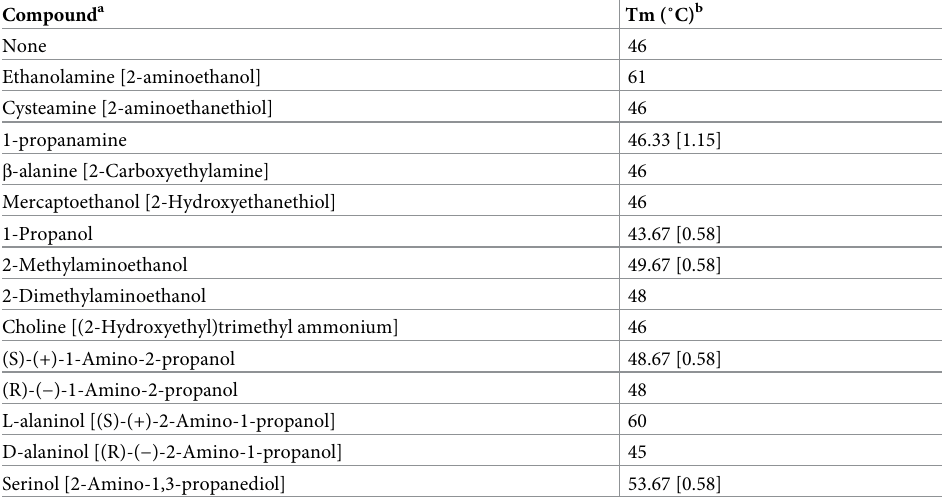
Table 1. Effects of ethanolamine and its analogs on the melting temp of CqsR-LBD. Compound a